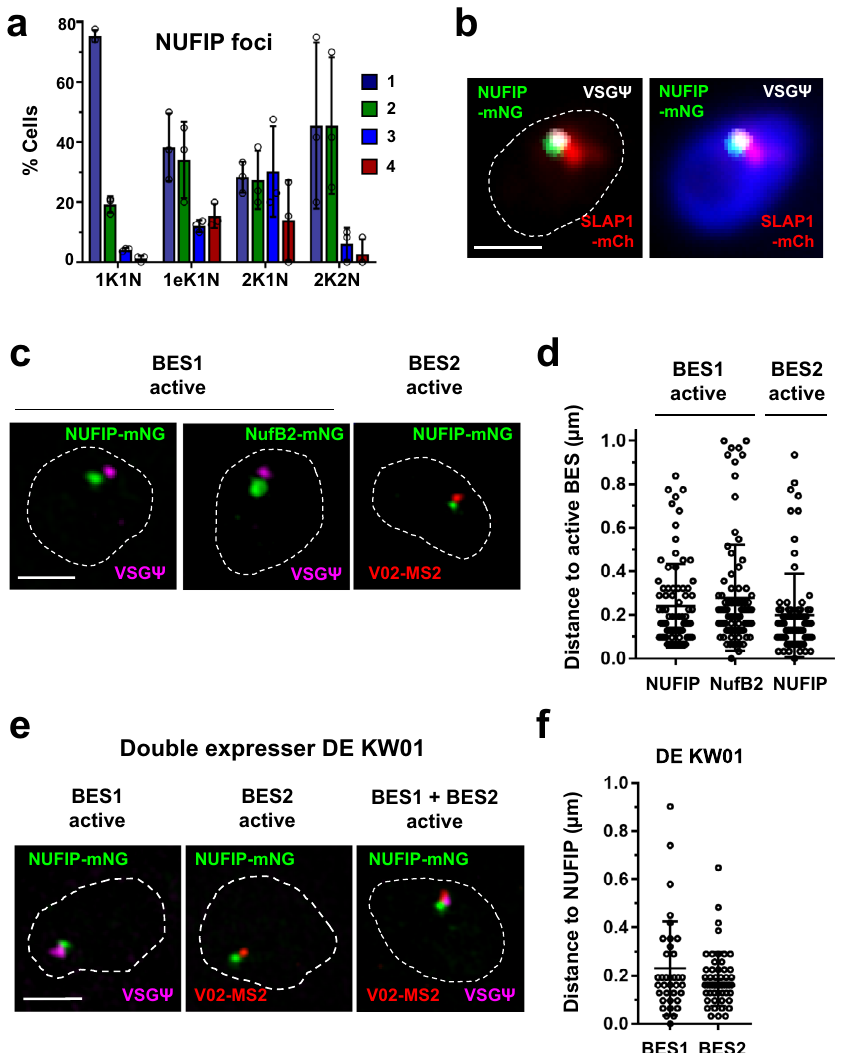
Fig. 5 The NUFIP body associates with the active ES in BF T. brucei . a Quantitation of the percentage (%) of BF T. brucei cells with different numbers of NUFIP foci (1 – 4) monitored using SR-SIM imaging. Different cell cycle stages are shown, with the number of kinetoplasts (K), elongated Kinetoplast (eK) or nuclei (N) indicated. Values are the averages from three biological replicates with error bars indicating ± SD. The values from individual replicates are shown with circles. For 1K1N n = 333, 1eK1N n = 76, 2K1N n = 49 and 2K2N n = 38. b Wide fi eld microscopy imaging of a BF T. brucei cell line with the SLAB and NUFIP bodies visualised, combined with RNA-FISH detecting BES1 nascent RNA using a VSG pseudogene probe (VSG Ψ , white). This line expresses mCh::SLAP1 (SLAP1-mCh, red) and NUFIP::mNG (NUFIP-mNG, green). The nucleus (dashed line) is stained with DAPI (blue). Scale bar = 1 μ m. c SR-SIM imaging of a nucleus (dashed line) from BES1 expressing BF T. brucei which has the NUFIP body components NUFIP (NUFIP-mNG, green) or NufB2 (BUFB2- mNG, green) epitope-tagged with mNeon green. BES1 nascent transcript is detected with a VSG pseudogene (VSG Ψ , magenta) probe. Alternatively, a BES2 expressing T. brucei line containing a MS2 repeat containing construct in BES2 was analysed which also had NUFIP epitope-tagged (NUFIP-mNG, green). BES2 nascent transcript were visualised with an MS2 probe (V02-MS2, red). Scale bar = 1 μ m. d Quantitation of the distance between BES1 or BES2 nascent RNA and NUFIP or NufB2 using the cells in ( c ). Values are the averages from at least two biological replicates with error bars indicating ±SD. For active BES1 to NUFIP n = 81, active BES1 to NufB2 n = 89 and active BES2 to NUFIP n = 79. e SR-SIM imaging of combined RNA-FISH detecting nascent BES1 RNA (VSG Ψ , magenta) or BES2 RNA (V02-MS2, red) with NUFIP::mNG (NUFIP-mNG, green). This was in BF T. brucei double-expresser cell line DE KW01-MS2-V02 where both BES1 and BES2 are unstably transcriptionally active. Scale bar = 1 μ m. f Quantitation of the distance from BES1 or BES2 nascent RNA to the NUFIP body using cells from ( e ) in which RNA from either BES1 or BES2 is detectable. Values are the averages from two biological replicates, with error bars showing ±SD. For BES1 to NUFIP n = 54, for BES2 to NUFIP n = 36. Source data are provided as a Source Data fi predicted RNA-recognition motif (Fig. 4a and Supplementary SL-RNA cap, an RNA modi fi cation essential for trans -splicing 32 . Fig. 7b, c). In T. brucei it has previously been found that NufB1, These data argue that the possible function of the NB is that of a NufB2, RBP34, NUFIP and ZNHIT3 all associate with kineto- splicing factor body involved in snRNP assembly and/or SL-RNA chore proteins, although the role of RNA processing in modi fi cation. chromosome segregation is unclear 30,31 . Interestingly, NufB1, We determined the position of the NB relative to the active ES using RNA-FISH and super-resolution microscopy, and found NufB2, RBP34 and NUFIP have previously been found to interact that it, as well as the SLAB, both invariably colocalised with the with CRK9 in T. brucei 32 , which is involved in methylation of the